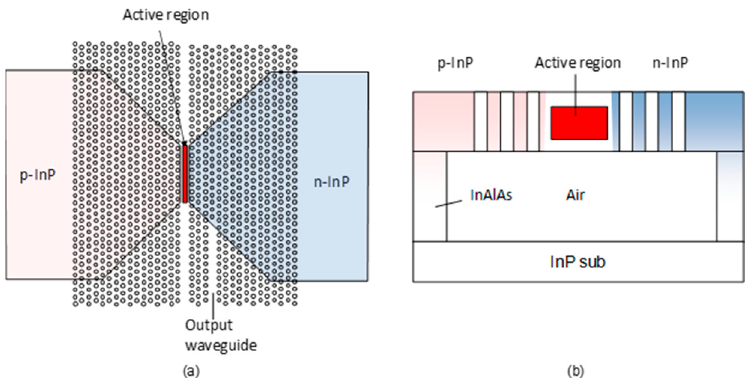
Figure 1. Schematics of the λ -scale embedded active region photonic crystal (LEAP) laser: ( a ) top view; ( b ) cross-sectional view. The wavelength-scale active region is embedded in a line-defect waveguide of InP-based photonic crystal (PhC). Since the refractive index of the active region is slightly higher than that of InP, an optical cavity is created around the active region without shifting the positions of the air holes. Typically, the effective refractive indices of the InGaAsP-based active region and the InP layer are 2.77 and 2.59, respectively.